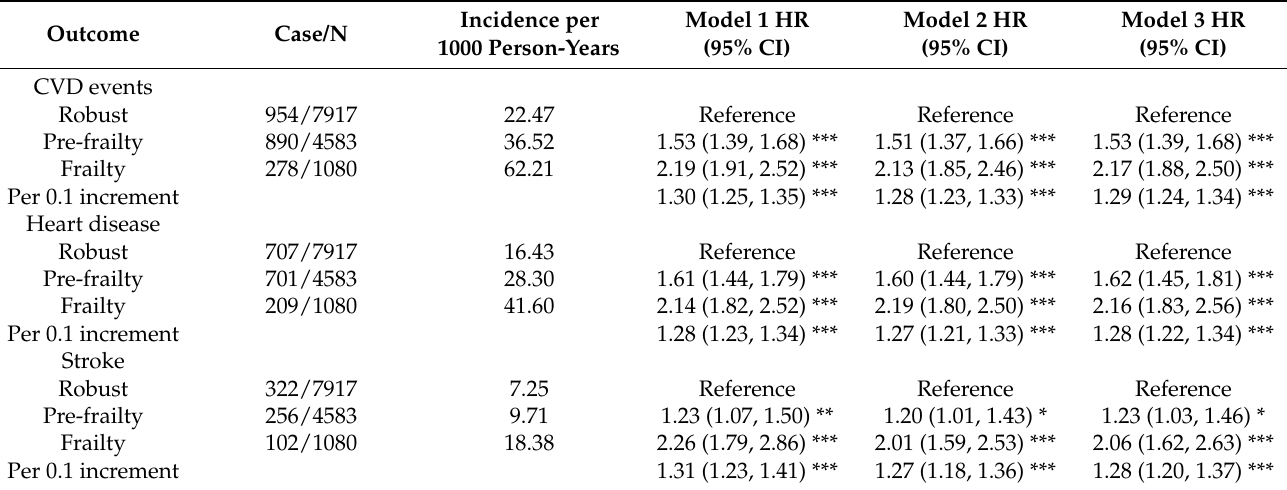
Table 2. Longitudinal association between the frailty index and CVD events.